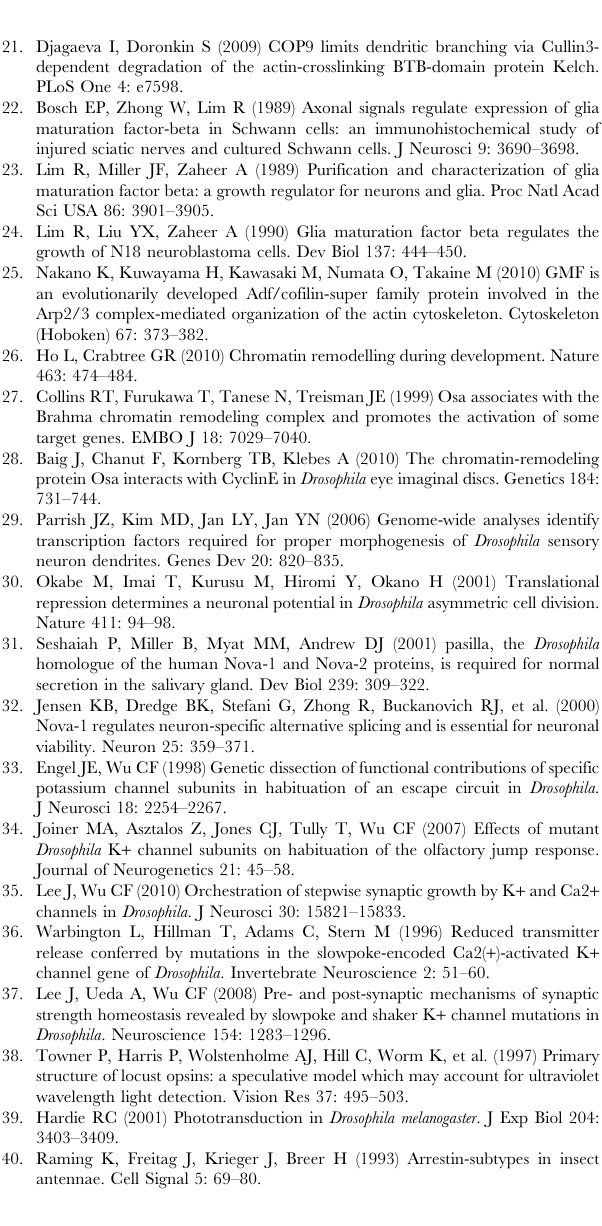
Table S1 Annotated differentially expressed genes. ID refers to the EST or GenBank ID; log 2 FC is the log2-transformed fold-change in expression in gregarious over solitarious CNS; p - values are false discovery rate (FDR)-adjusted, with a cut-off at FDR = 10%. Table S2 Non-annotated differentially expressed genes. ID refers to the EST or GenBank ID; log 2 FC is the log2- transformed fold-change in expression in gregarious over